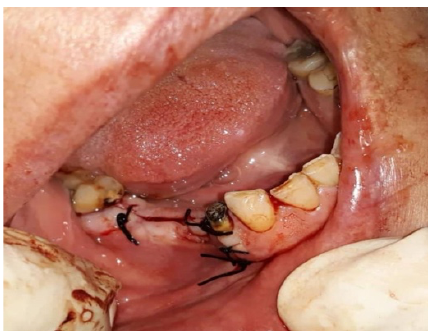
Figure 6. The suture.